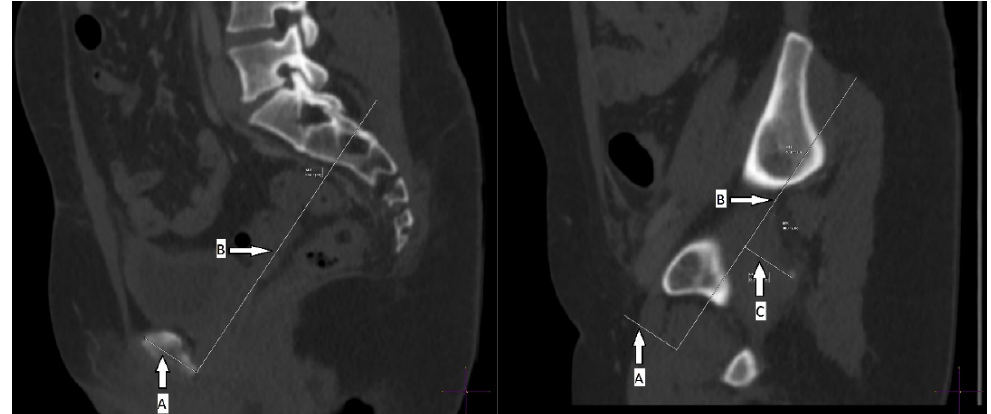
Figure 1. Lines A and B are drawn on the sagittal plane that crosses the pubic symphysis ( left ). Lines A, B and C are drawn on the plane that crosses the top of the left ischial spine. Line C is the SID distance ( right ). symphysis–ischial spine distance (SID).